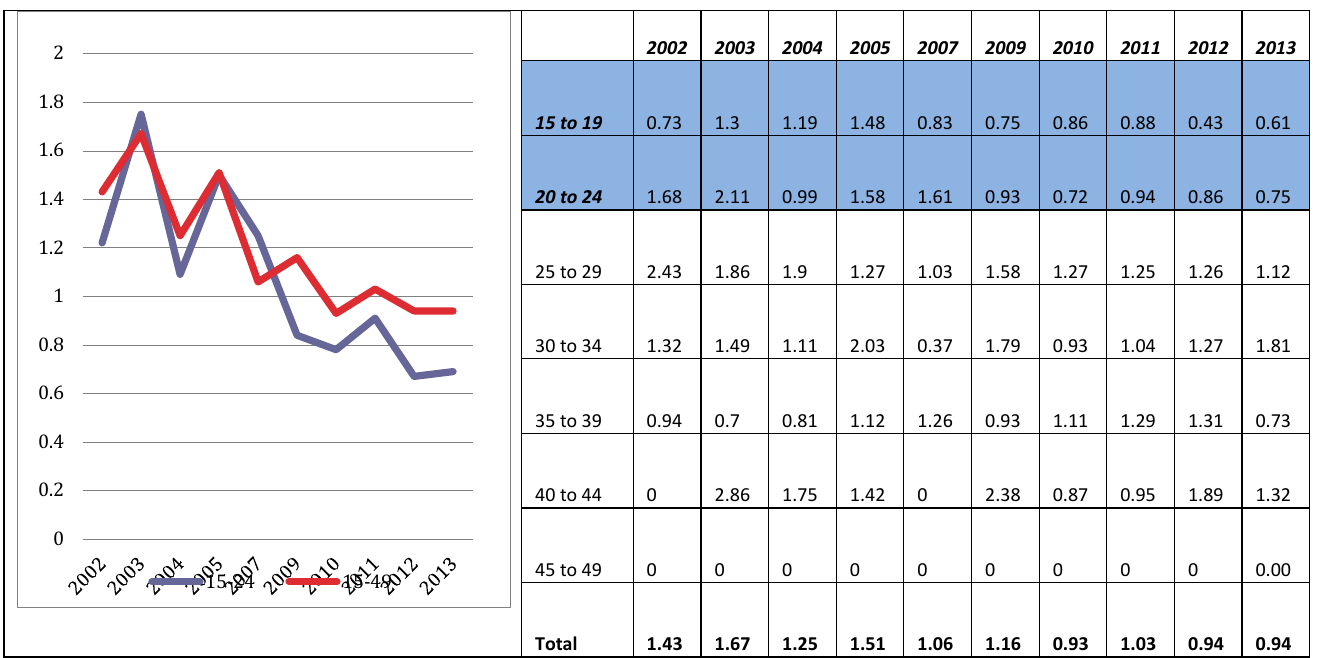
Figure 5: HIV Prevalence among 15-24 years ANC attendees and all attendees, 15-49 years, 2002-2012